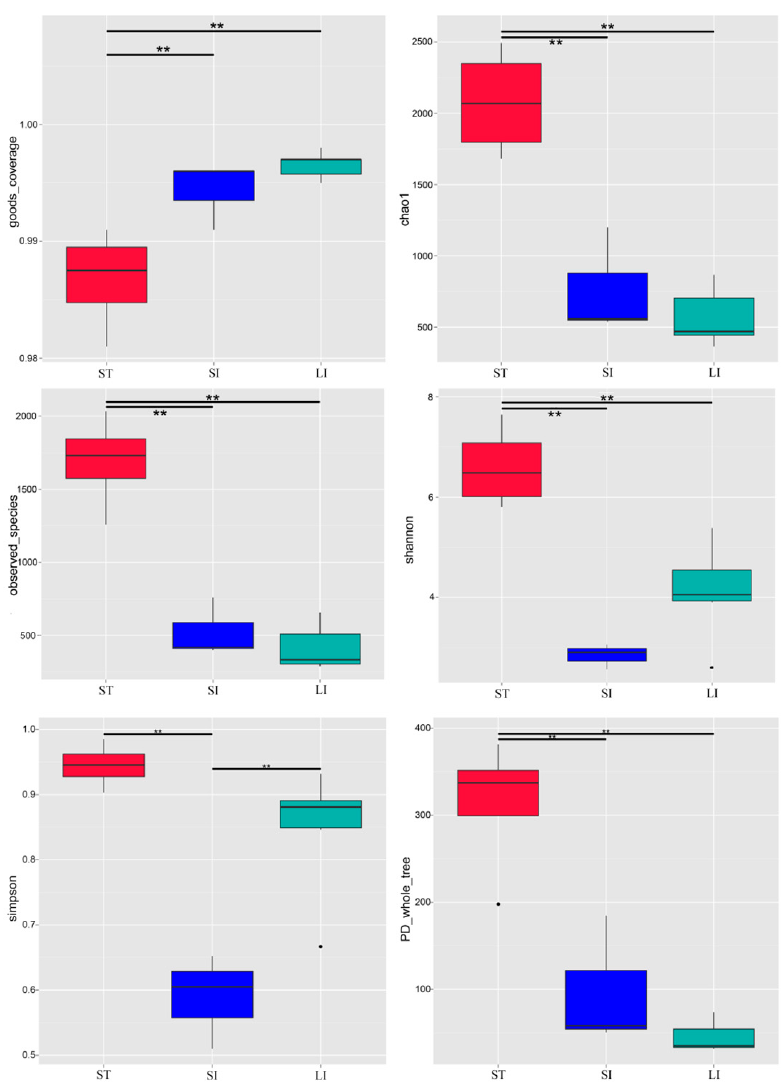
Figure 1. Alpha diversity analysis of the different segments of the gastrointestinal tract of L. rufozona- tus . Abbreviations: LI, large intestine; SI, small intestine; ST, stomach; **: p < 0.01.